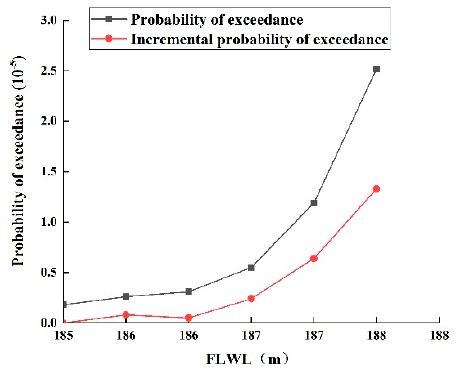
Figure 3. Probability of exceedance and increases in the post-flood season.